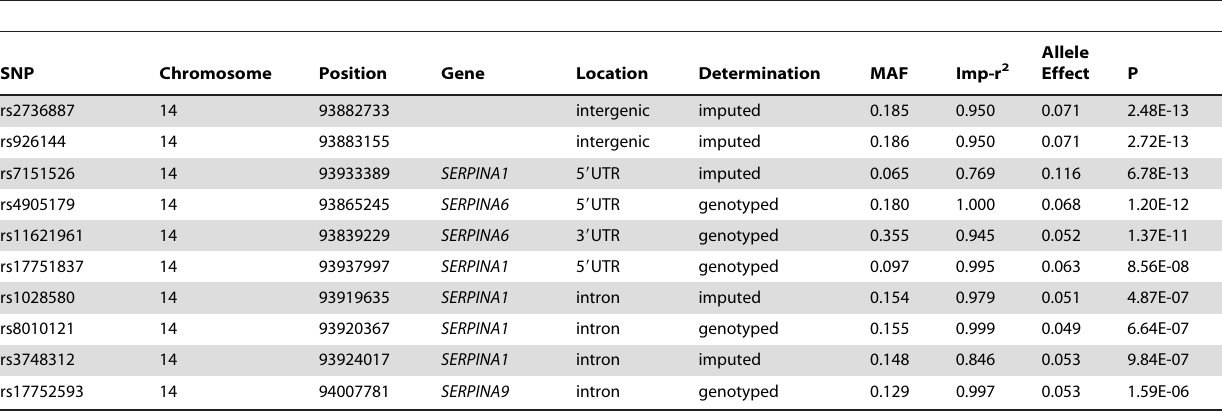
Table 1. The ten most strongly associated SNPs in the unconditional GWAS on AAT serum level in SAPALDIA (N =1392).